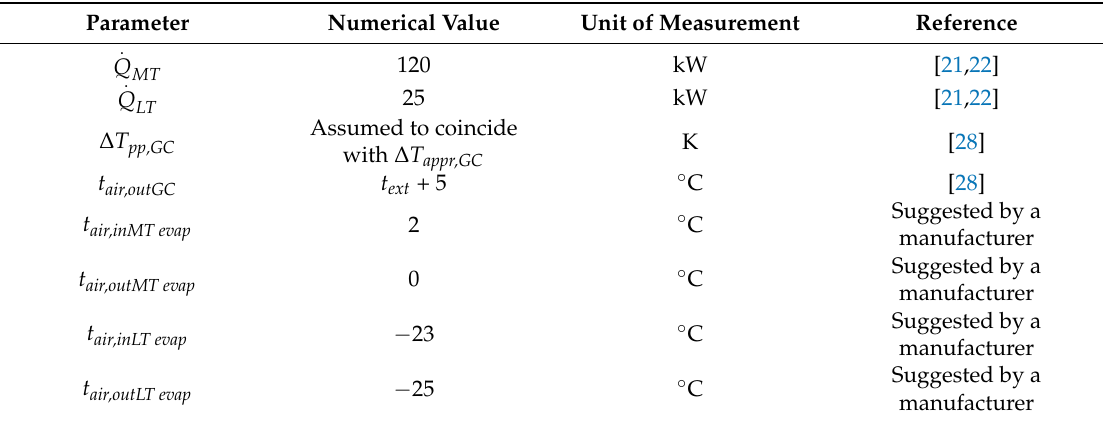
Table 3. Assumptions in common in all the implemented